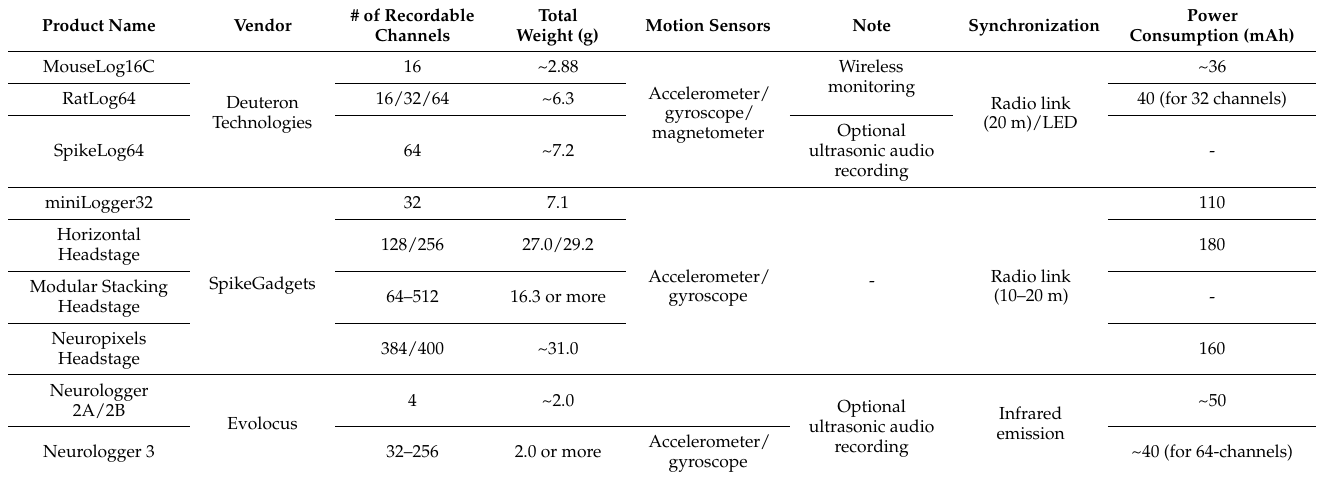
Table 1. Neurologger specifications. The total weight of the Modular Stacking Headstage (SpikeGadgets, CA, USA) and Neurologger 3 (Evolocus, NY, USA) depends on the configuration. The number of recordable channels for Neuropixels Headstage (SpikeGadgets) was 384 for one Neuropixels 1.0 probe, but 400 channels are available across three Neuropixels 1.0 probes. The wireless monitoring function implemented in neurologgers produced by Deuteron Technologies is immensely effective in outdoor experiments, specifically if electrode adjustment is